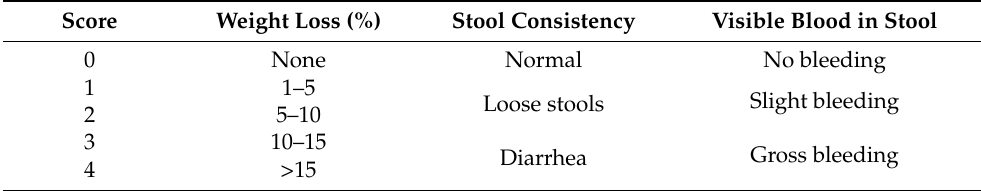
Table 1. Disease activity index (DAI) parameters and their related scoring